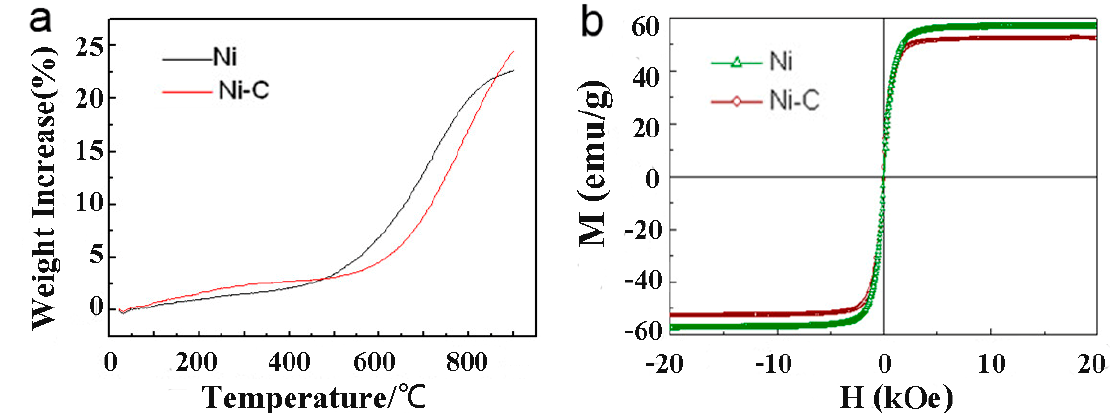
Figure 5. Physical properties of initial Ni powder and carbon ‐ encapsulated nickel particles (CENPs). ( a ) TGA curves measured in air and ( b ) M–H curves tested at room temperature.